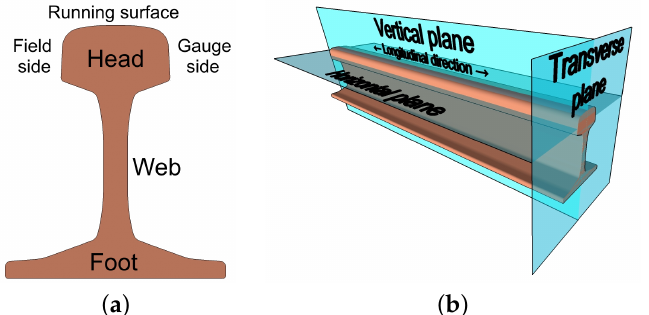
Figure 1. Representation of the terminology commonly adopted in the description of rails: ( a ) transverse section; ( b ) reference